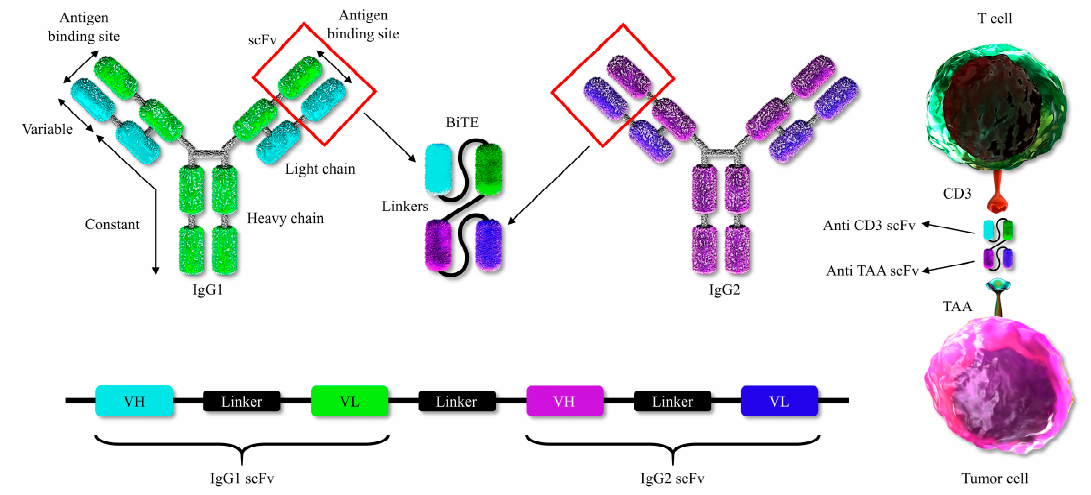
Figure 3. Engineering of a bispecific T cell engager (BiTE) antibody. Production of a BiTE antibody from the variable domains of two separate monoclonal antibodies (see text for details).